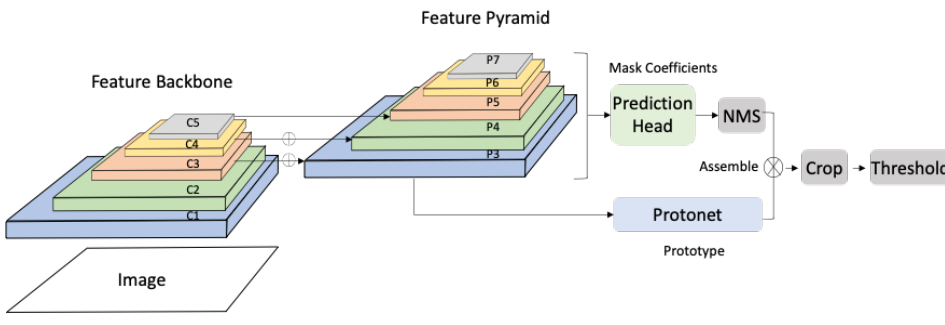
Figure 6. Architecture of